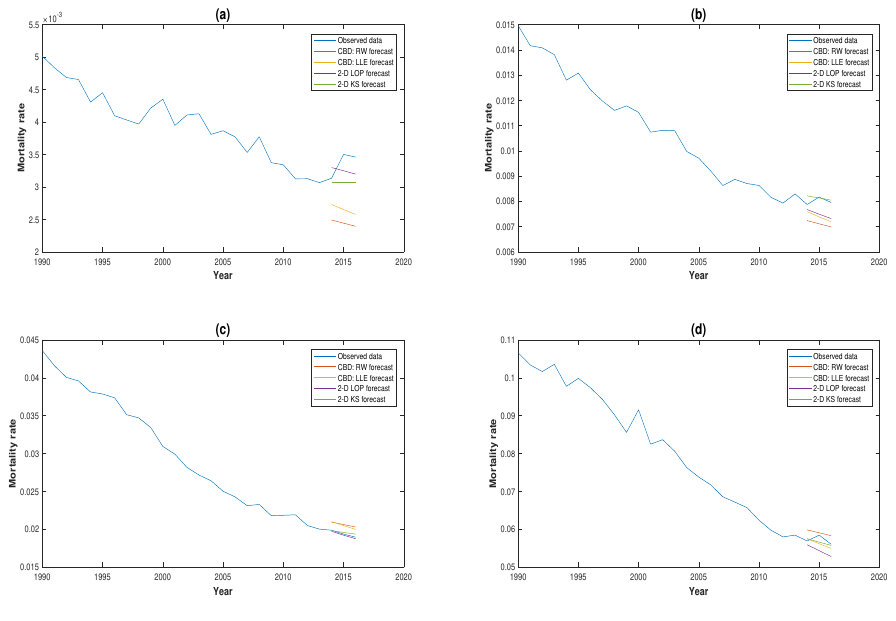
Figure 2. Three-year-ahead forecast from 2014–2016 for GB males aged ( a ) 50, ( b ) 60, ( c ) 70 and ( d ) 80 based on mortality data since